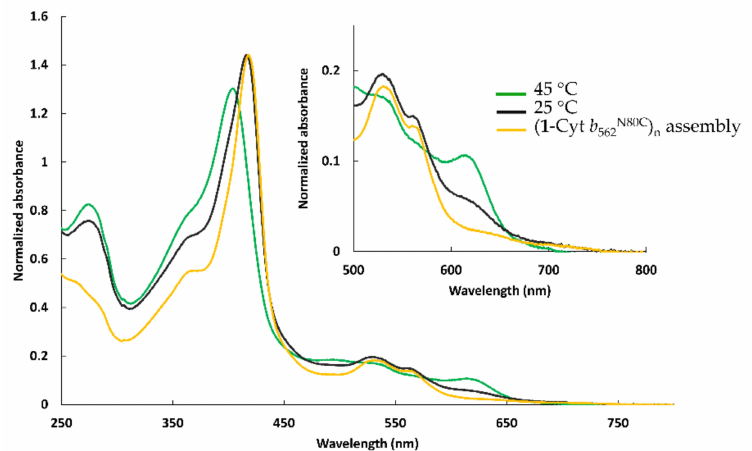
Figure 4. UV-Vis spectra measured at pH 7.0 in 0.1 M potassium phosphate buffer of mixture of ( 1 -Cyt b 562N80C ) n and apoHTHP under the equimolar conditions with respect to the amount of heme-binding site at 25 ◦ C (black) and at 45 ◦ C (green) with UV-Vis spectrum of ( 1 -Cyt b 562N80C ) n